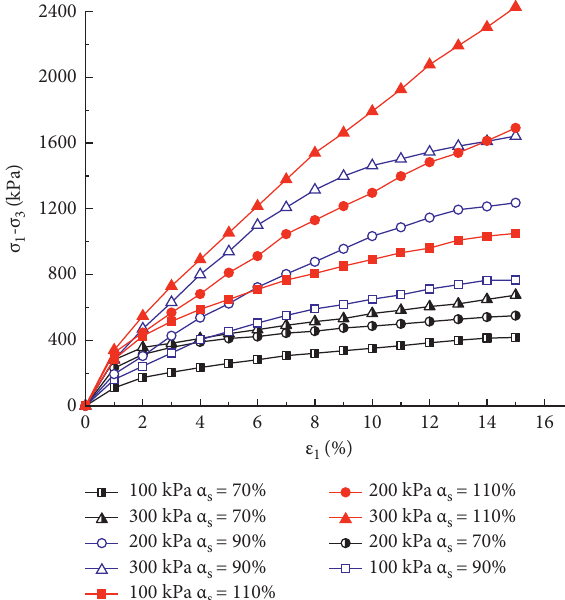
Figure 8: Relationship between principal stress difference and axial strain ( ω �